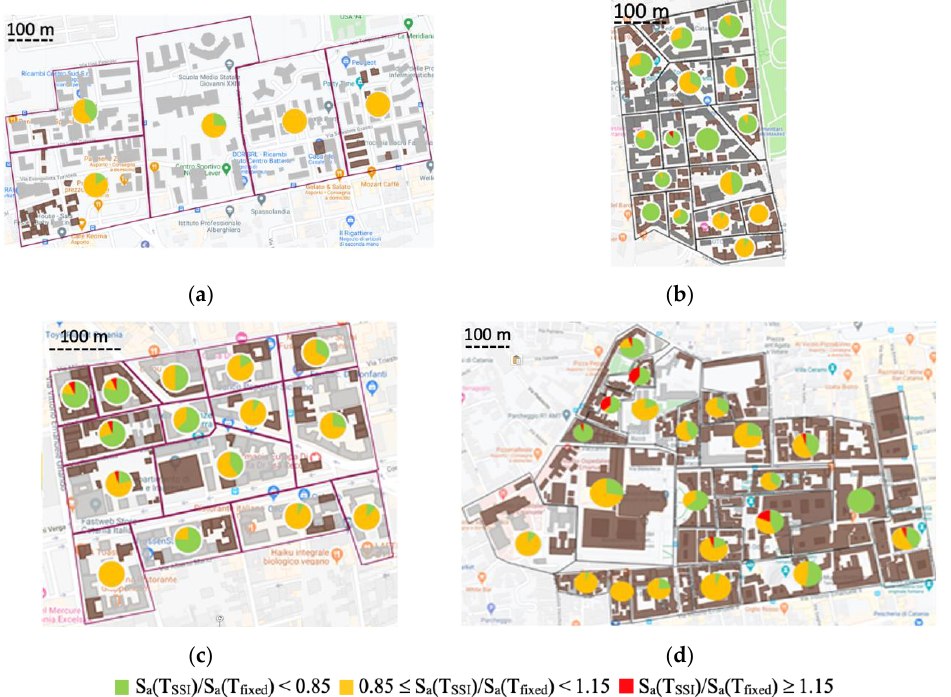
Figure 13. Spatial distribution of S a ( T SSI )/ S a ( T fixed ) ratios for the 2018 seismic input: ( a ) west area; ( b ) northeast area; ( c ) north Old Town; ( d ) south Old Town.